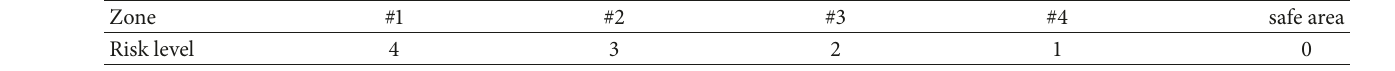
Table 6: Risk level of the zones in Figure 3 based on gas concentration.